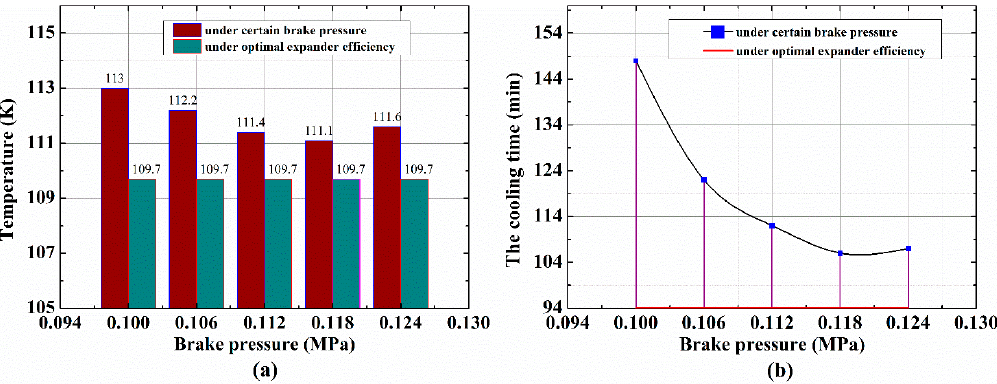
Figure 7. Comparisons between different conditions: ( a ) Ultimate refrigerating temperature; ( b ) the cooling time to 113.0 K under different operation modes.